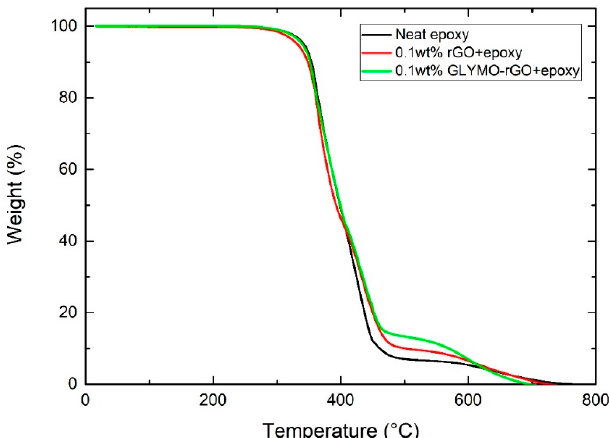
Figure 10. TGA spectra obtained from neat epoxy and nanocomposites containing 0.1 wt% rGO and 0.1 wt%